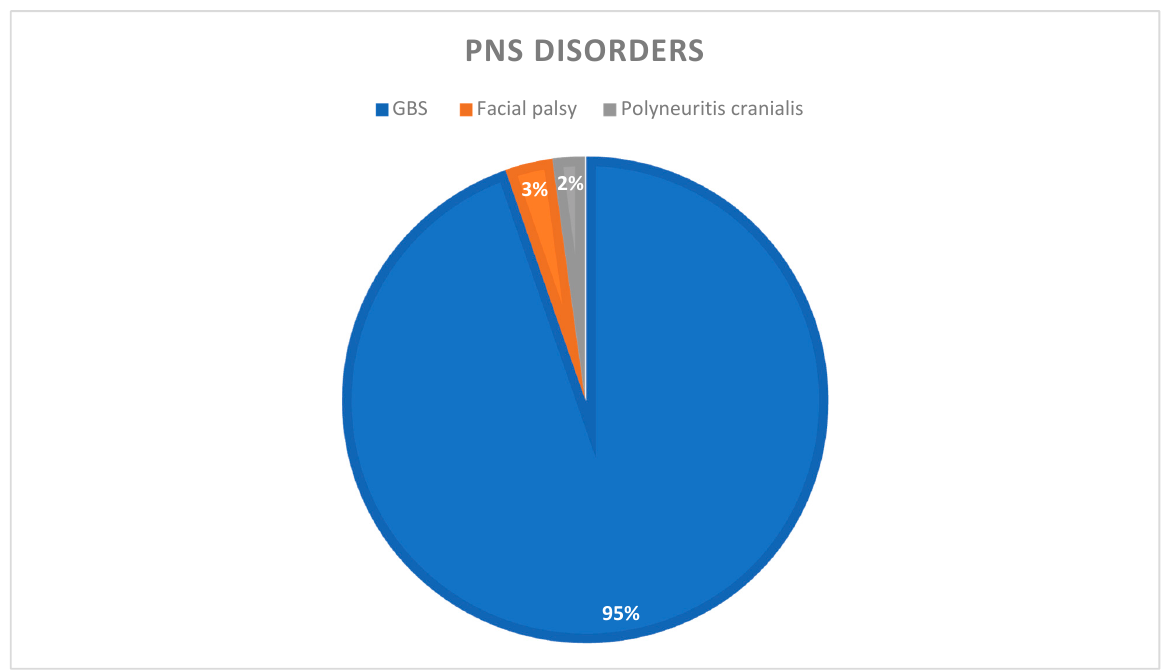
Figure 3. Pie chart showing distribution of various PNS disorders post COVID-19. GBS, Guillain–Barré syndrome. Table 6. Demographics and PNS manifestations in the 94 patients.